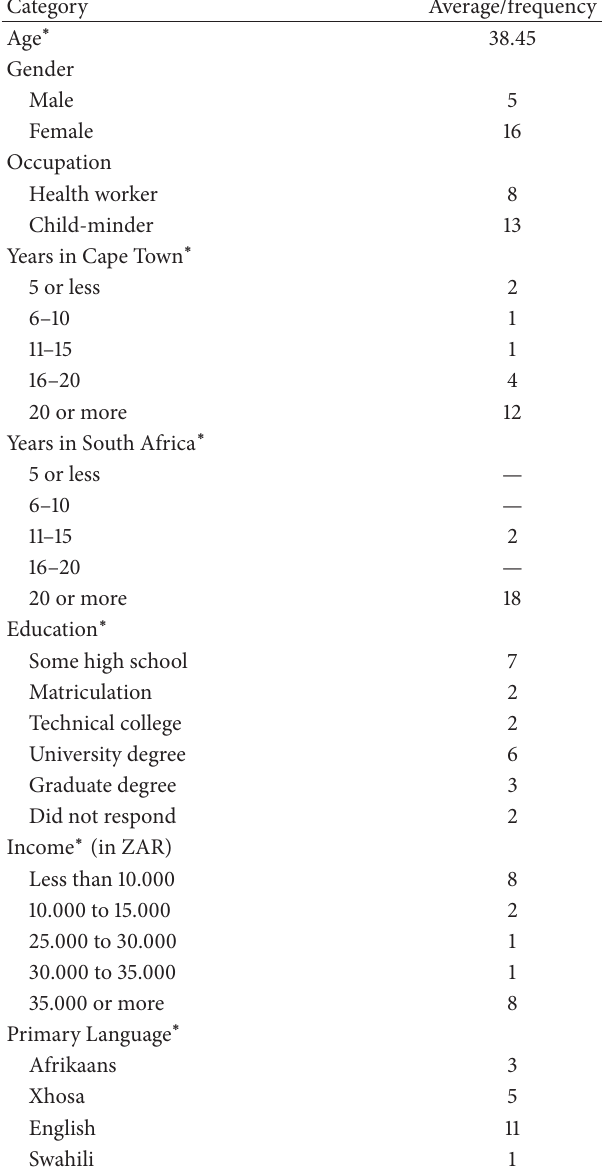
Table 2: Frequency of demographic characteristics, ( 𝑛 = 21